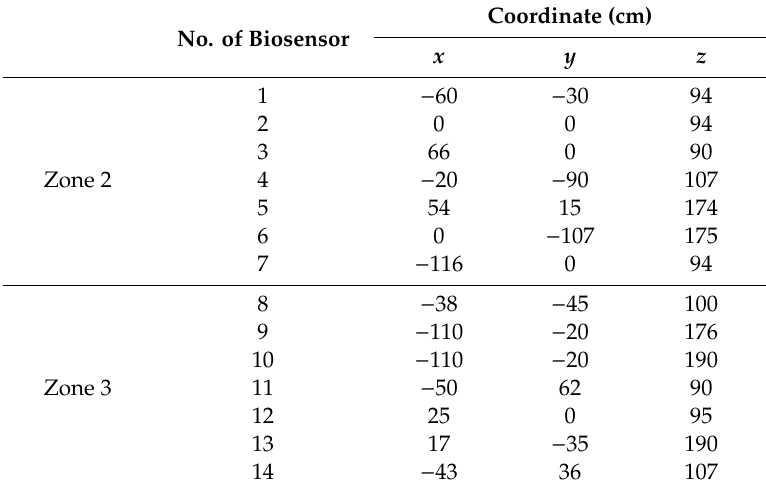
Table 2. Biosensor coordinates (center of trunk considered as the origin of coordinates).